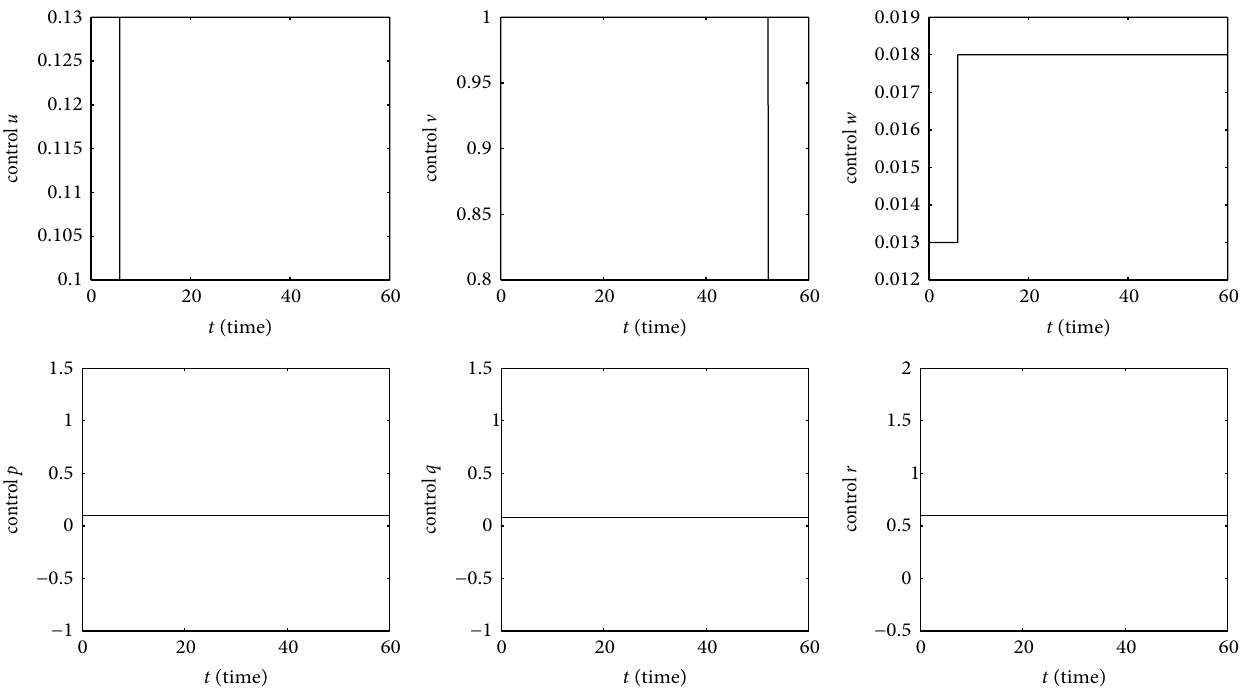
Figure 4: Optimal controls for 푇 = 60.0 : upper row: 푢